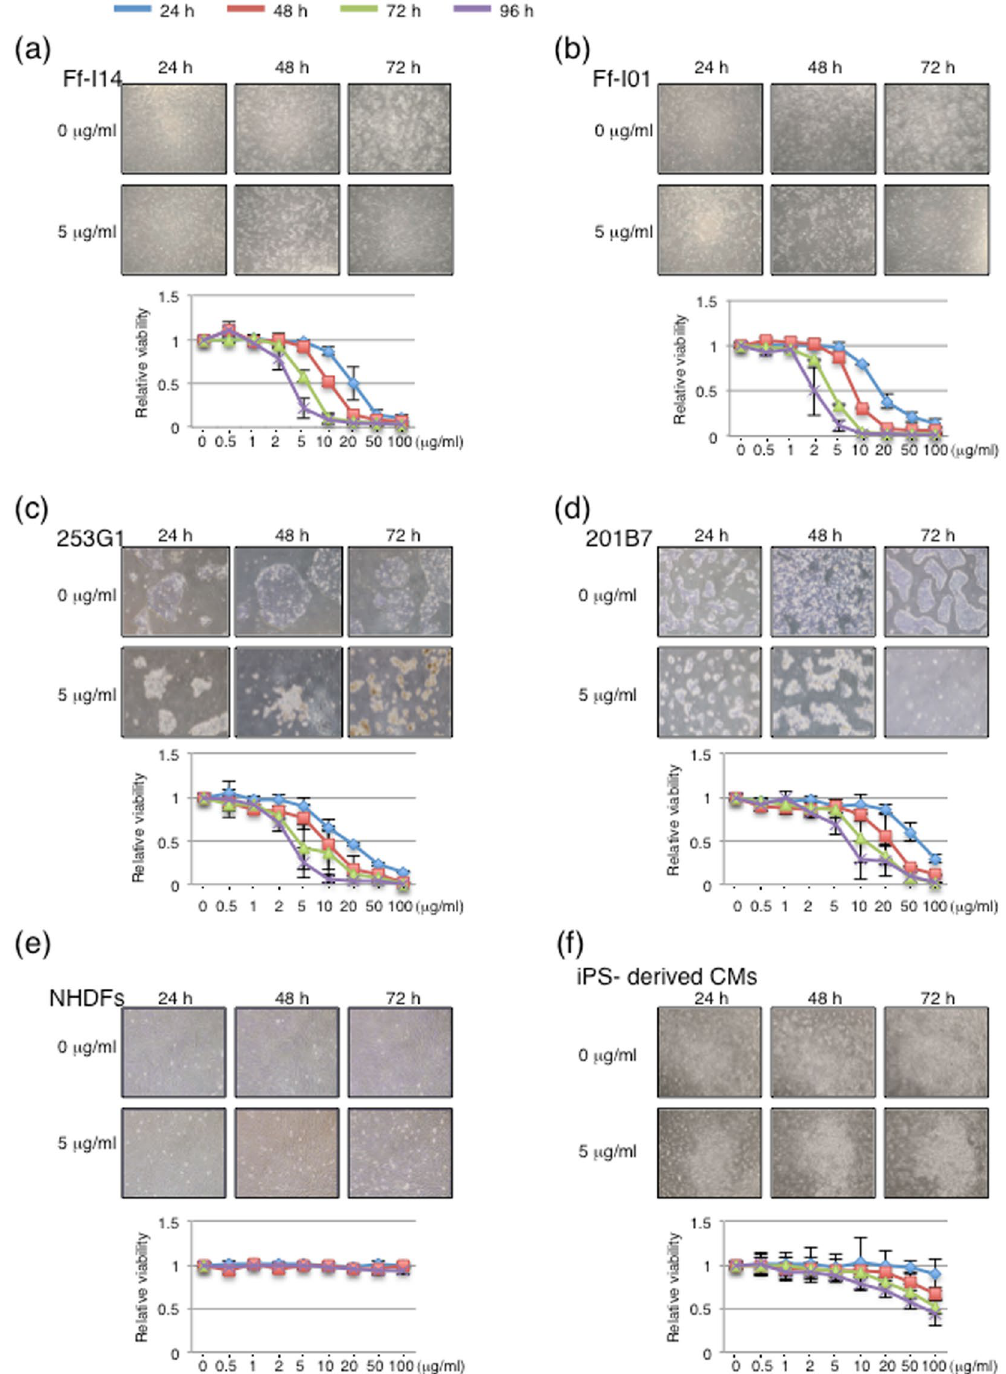
Figure 2. Effect of brentuximab vedotin on viability of hiPSCs and differentiated cells ( a ) Ff-I14 cells, ( b ) Ff- I01 cells, ( c ) 253G1 cells, ( d ) 201B7 cells, ( e ) NHDFs, and ( f ) iPSC-derived CMs were treated with brentuximab vedotin at 0, or 5 μ g/ml for 24, 48, and 72 h. Panels are representative phase-contrast images of cells. The relative viabilities of cells in response to brentuximab vedotin treatment were determined using CCK-8 solution. Graph data were repeated at least three times